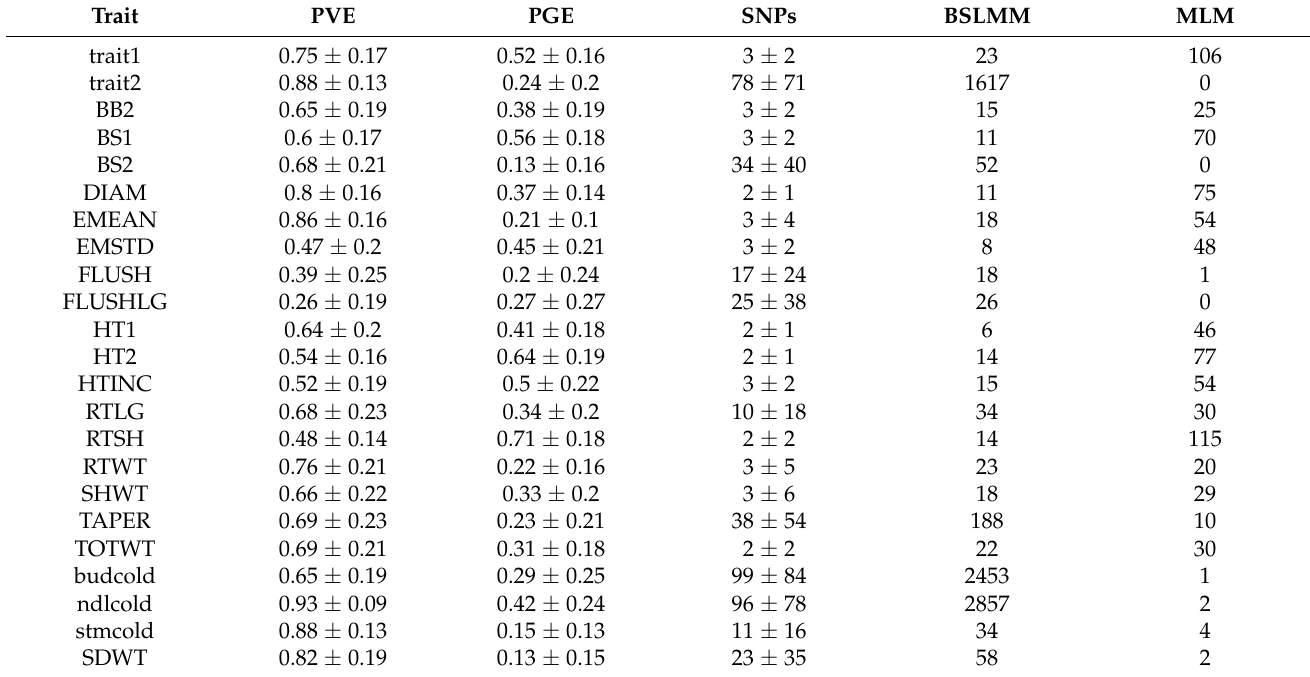
Table 1. Genetic architecture of cold-related phenotypic traits in coastal